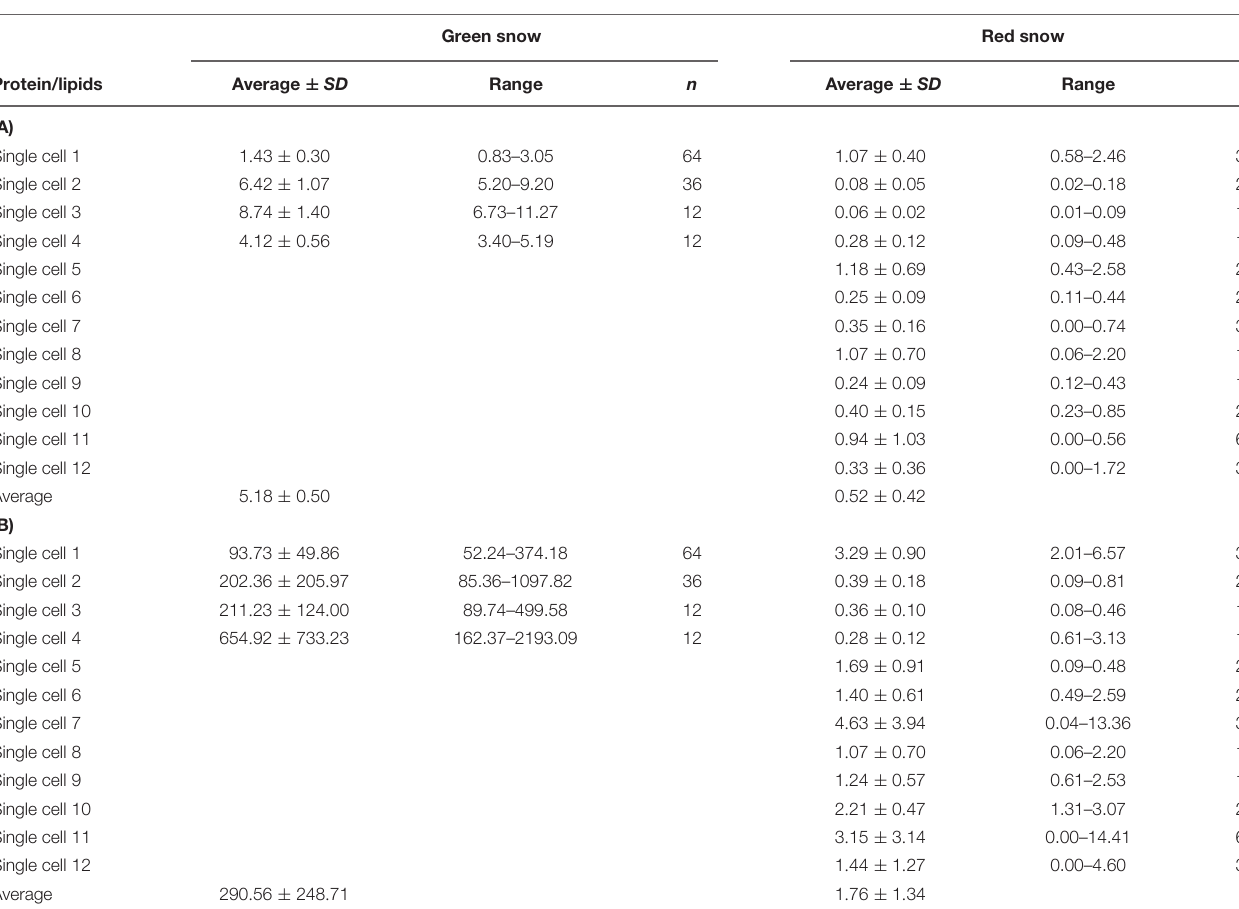
TABLE 9 | (A) Ratios of functional group areas corresponding to proteins (amides I and II, 1700–1500 cm − 1 ) and lipids (lipids I–IV, 3050–2800 cm − 1 ) of single cells in green and red snow derived from synchrotron radiation infrared spectroscopy. (B) Ratios of functional groups areas corresponding to proteins (amides I and